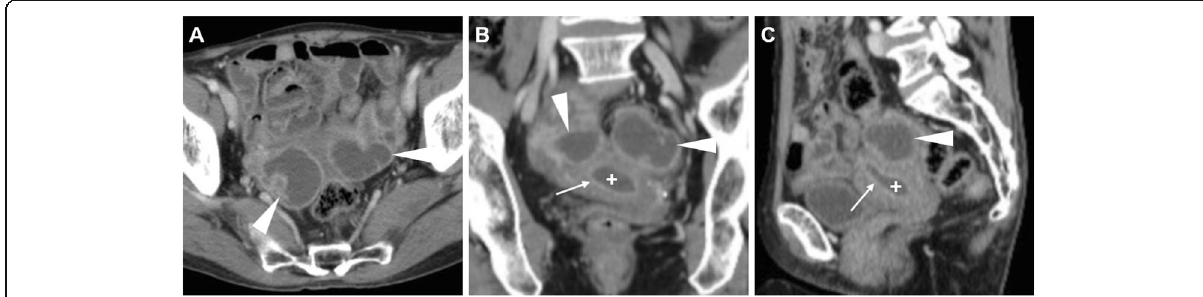
Fig. 22 a – c Multiplanar CT images of genital involvement in a 58-year-old woman with respiratory tuberculosis, showing bilateral adnexal